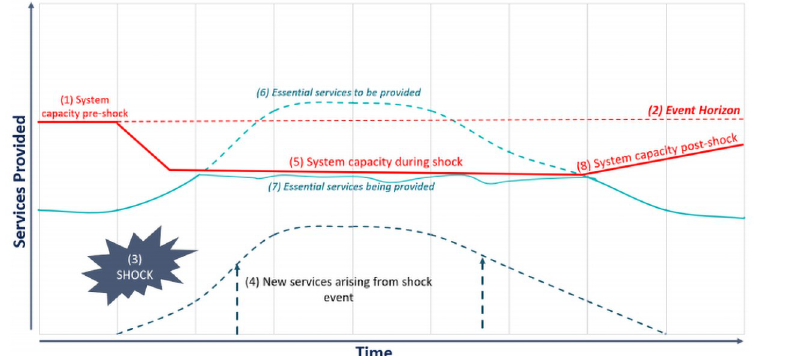
Fig 1. Effects of a shock event on provision of essential